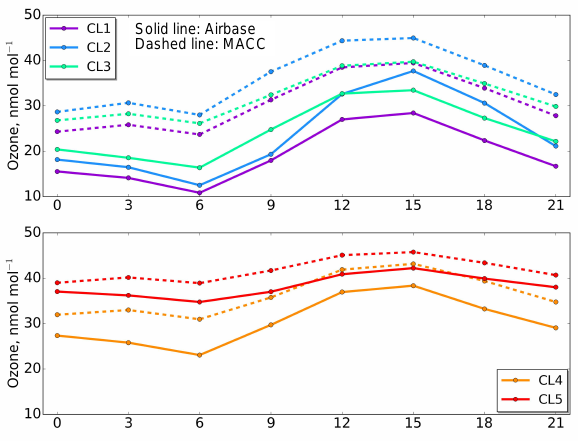
Figure 12. Seasonal cycles of cluster centroids; Airbase vs. MACC, first CA.